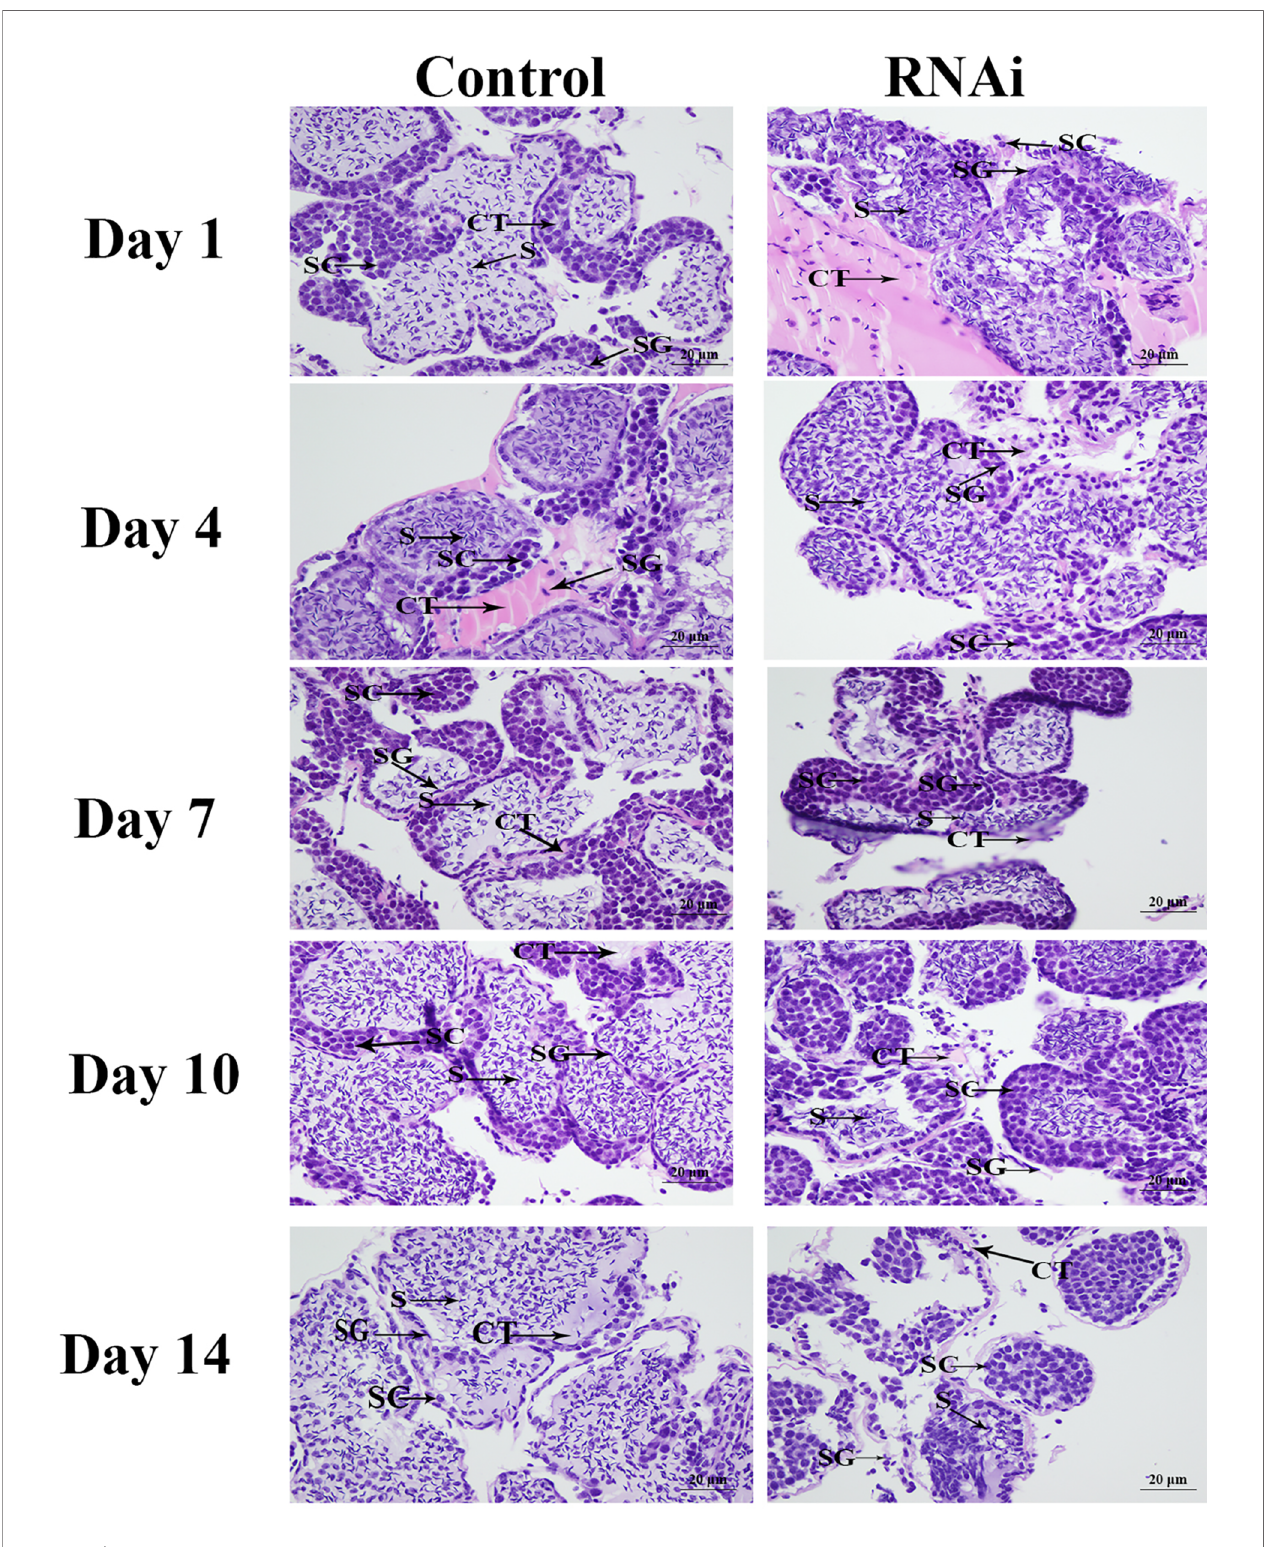
FIGURE 9 | The histological observations of testis between RNAi and control group. SG, Spermatogonia; SC, spermatocyte; S, sperm; CT, collecting tissue. Scale bars = 20 m m.